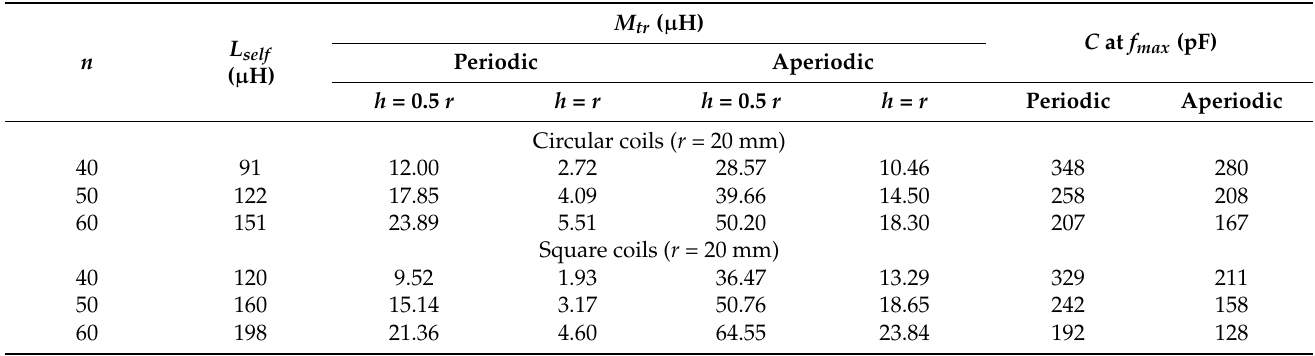
Table 4. The values of the compensating capacity at f max = 1 MHz, self, and mutual inductance for small circular and square coils ( r = 20